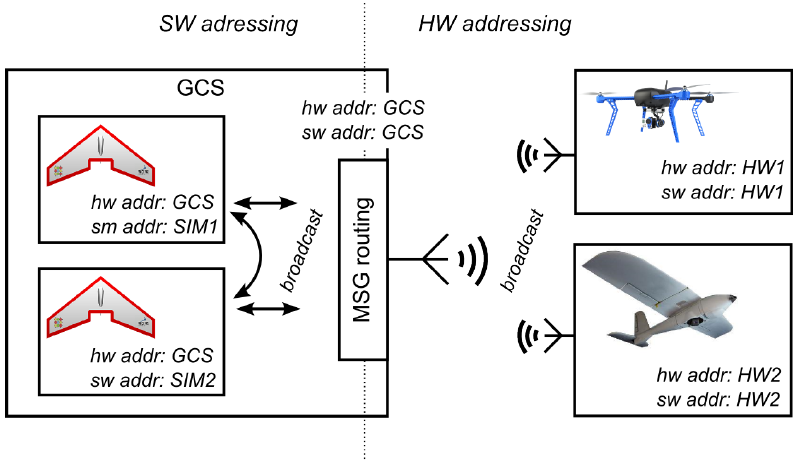
Figure 3. Dual addressing in MR communication system and distribution of advertisment